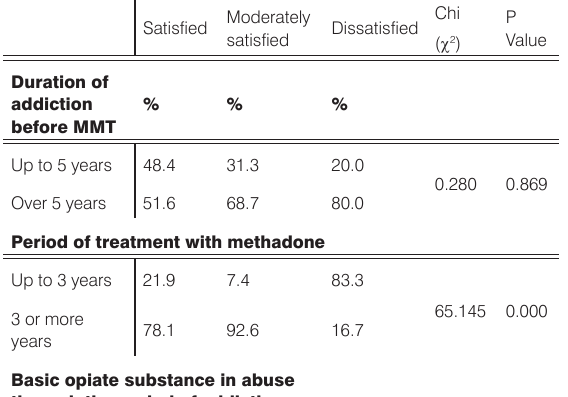
Table 3. Clinical characteristics of the underlying disease in relation to the degree of social functioning of the addicts Chi Moderately Satisfied Dissatisfied satisfied ( c 2